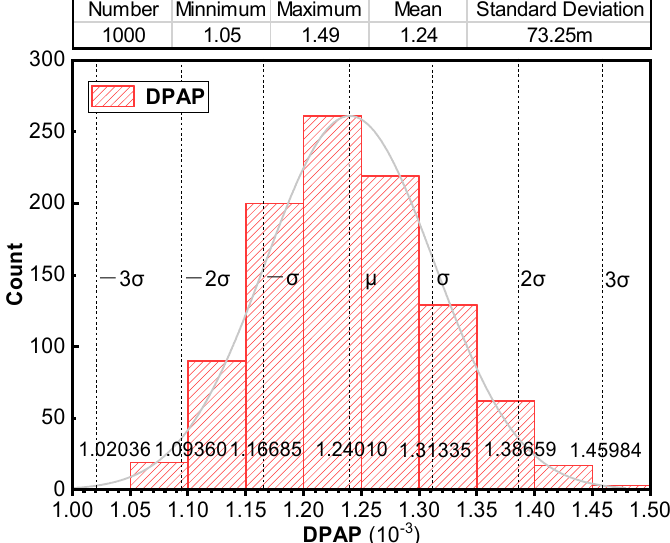
Figure 13. Monte Carlo simulation results of DPAP on process variation.